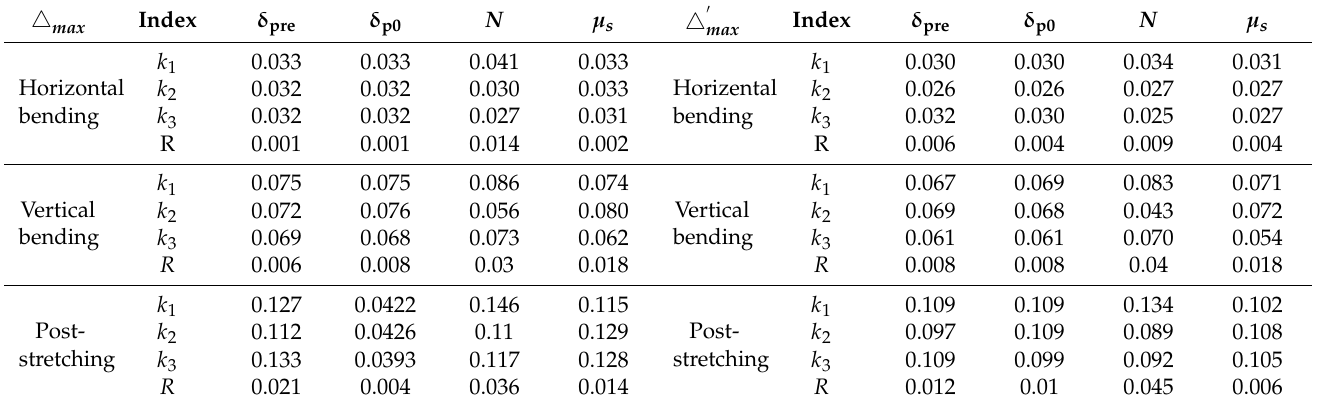
Table 3. Range analysis